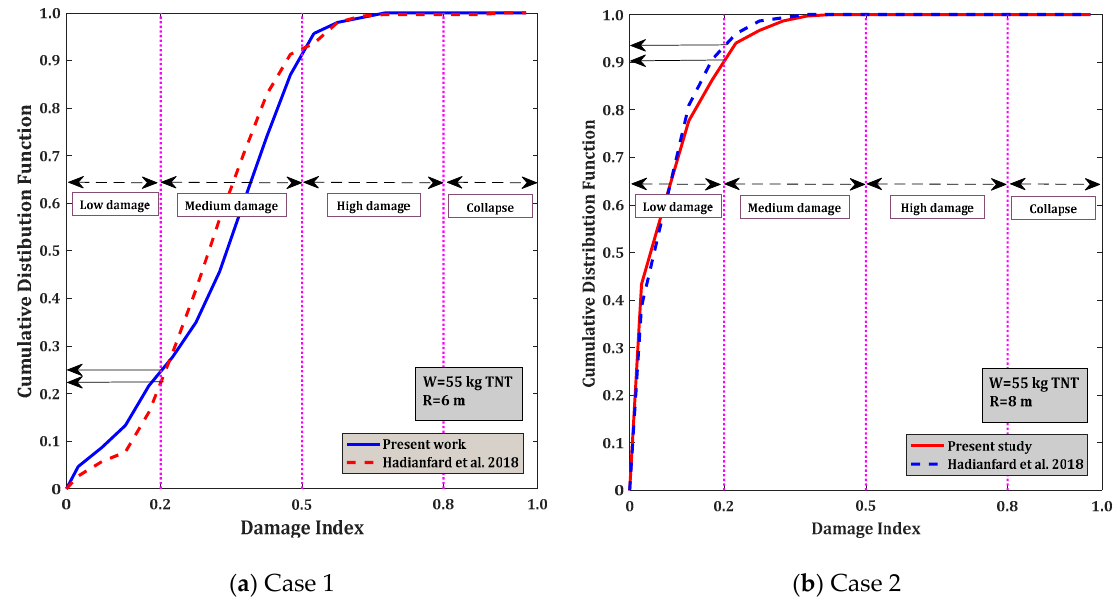
Figure 5. Comparison of the results of MCS based on beam (present study) and shell element types [52] for CDFs of DI: ( a ) Case 1; ( b ) Case 2.